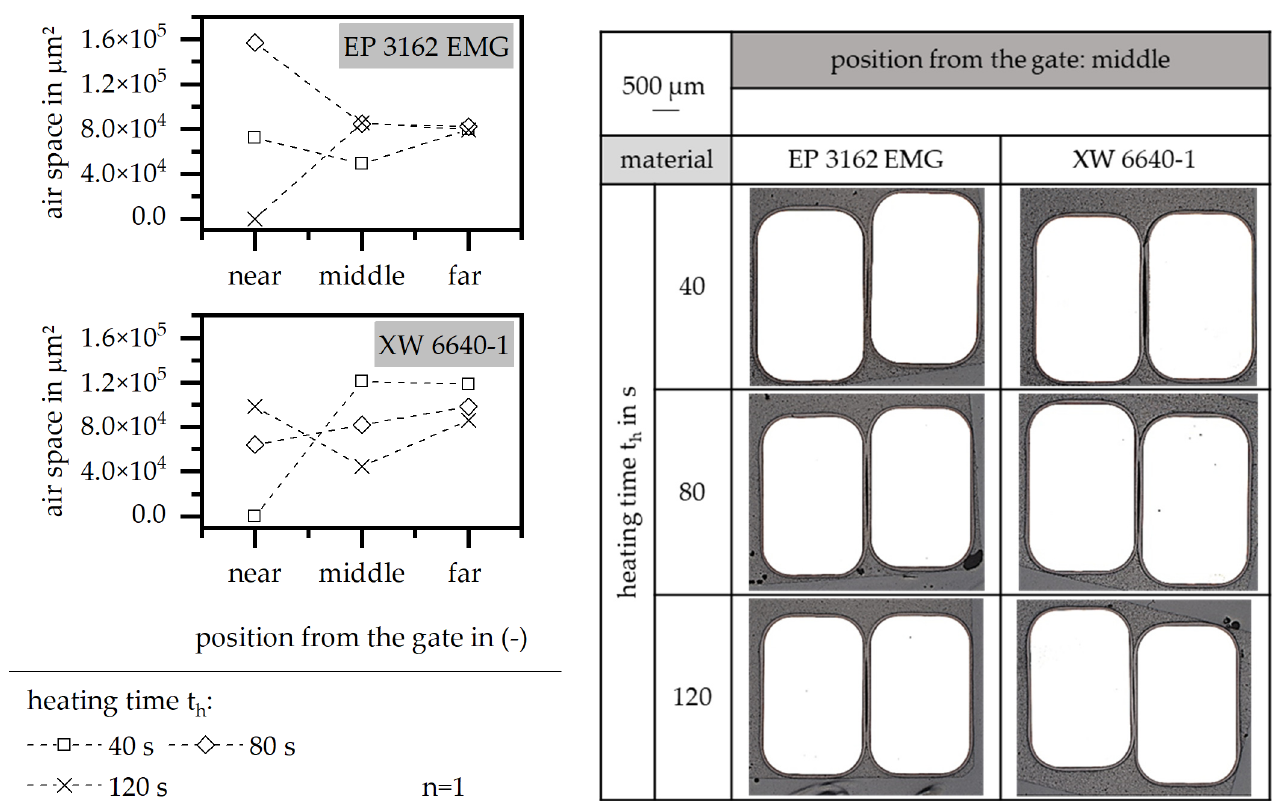
Figure 13. Airspace and position of the wire relative to the stack, relative to the heating time in the insulation system.